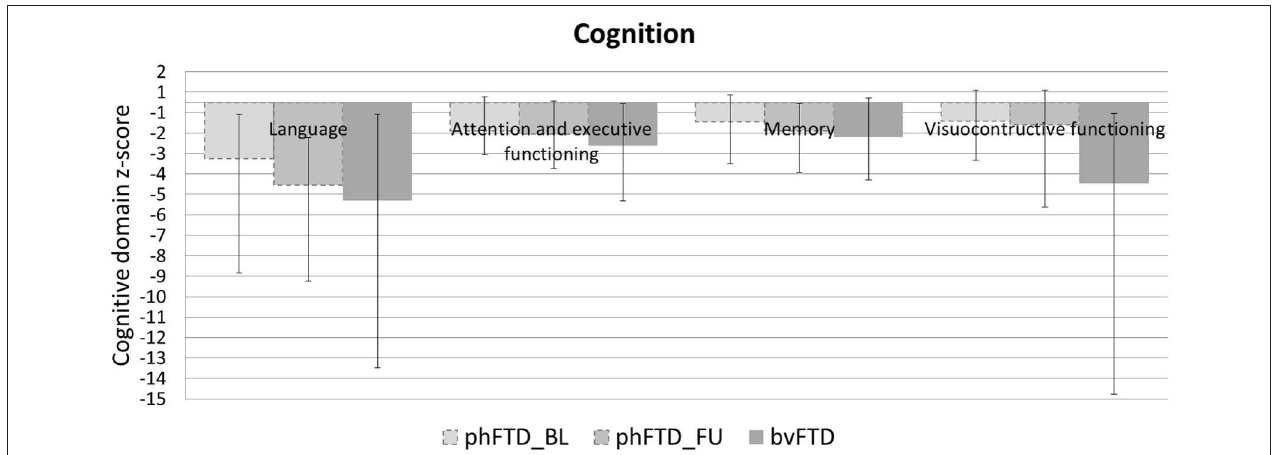
FIGURE 1 | Mean cognitive domain z-scores for each group (baseline phFTD, follow-up phFTD, bvFTD). Z-scores are calculated using means of controls as a reference (i.e., control mean = 0, hence not visible in the graph). The range of scores is indicated by a minimum-maximum bar. Domains assessed were language, attention and executive functioning, memory, and visuoconstructive functioning. bvFTD, behavioral variant frontotemporal dementia; phFTD, phenocopy frontotemporal dementia; BL, baseline; FU, follow-up.